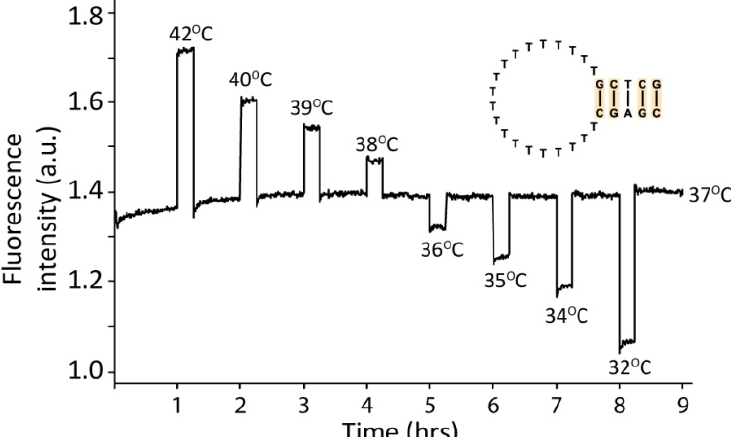
Figure 2. Fluorescence measurements with a dye-labeled DNA hairpin subjected to various temperatures in the range from 32 °C to 42 °C as indicated. The hairpin was first incubated at 37 °C for 60 min and then at 42 °C for 15 min. Following this was several cycles of incubation at alternately 37 °C and a test temperature for 45 min and 15 min, respectively. The hairpin sequence is as